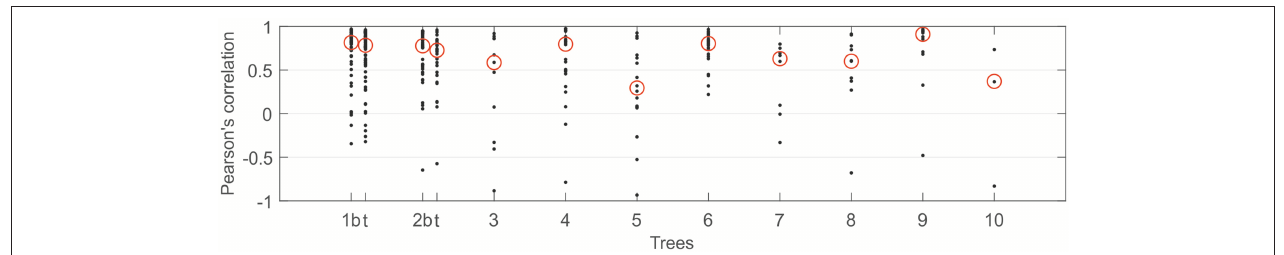
FIGURE 2 | Daily Pearson’s correlation coefficients between resin pressure and temperature per each continuously measured Scots pine tree at SMEAR II station in 2017. Approximate median value over the correlation coefficients highlighted with a red circle. With trees 1 and 2, t presents results from top part of stem and b from bottom part of